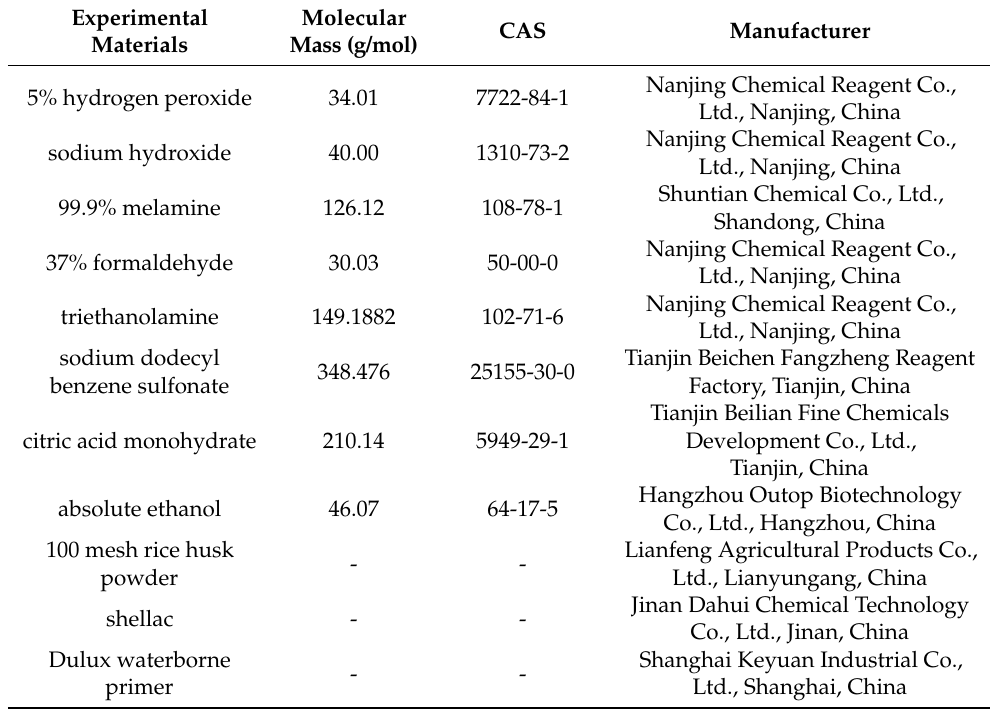
Table 1. List of experimental